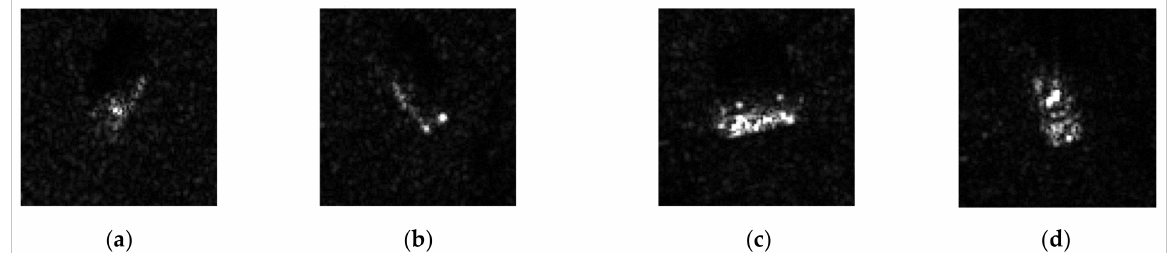
Figure 5. Examples of MSTAR dataset: ( a ) “BMP2”-class with 26.49 pose angles and 17 depression angles, ( b ) “2S1”-class with 143.33 pose angles and 17 depression angles, ( c ) “T62”-class with 256.52 pose angles and 17 depression angles, ( d ) “ZSU234”-class with 347.99 pose angles and 15 depression